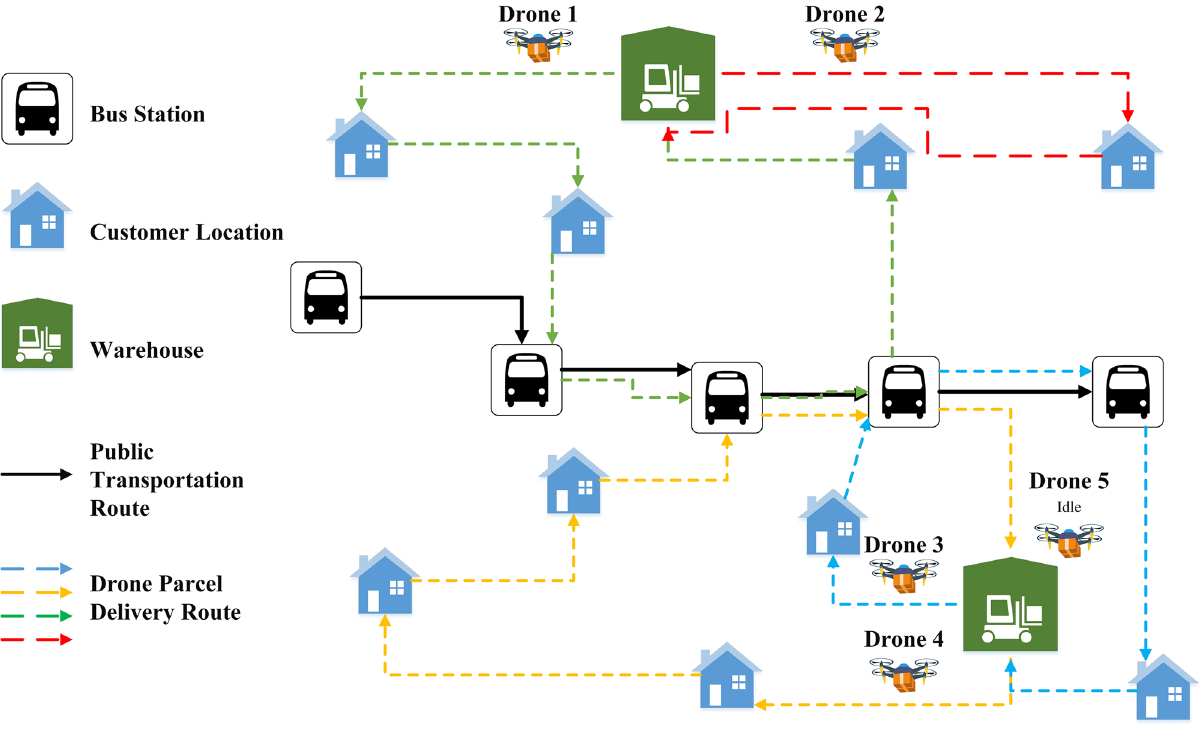
Figure 1. A general depiction of the proposed drone delivery